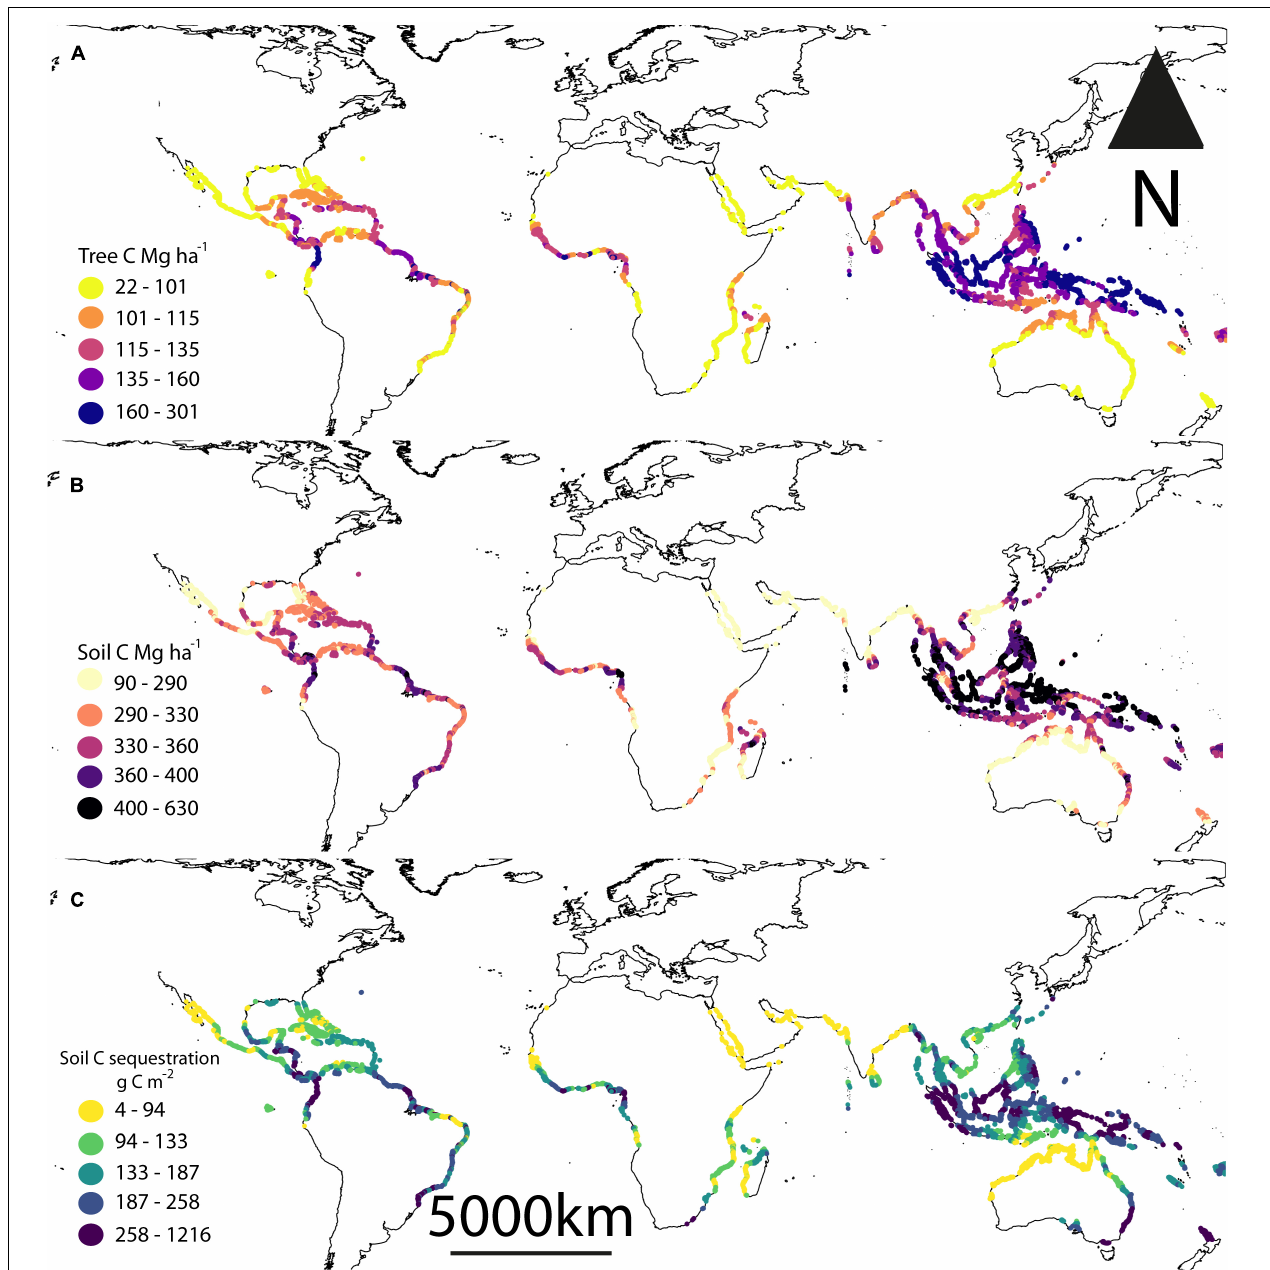
FIGURE 1 | Estimated current global C stocks in mangrove (A) trees, (B) soils to 1 m depth, and (C) mangrove soil sequestration rates. Data presented are mean predicted values from present day climate datasets. Tree carbon was estimated from a model developed by Hutchison et al. (2014) and the soil carbon and sequestration rates estimates were from modeling performed by the current study.